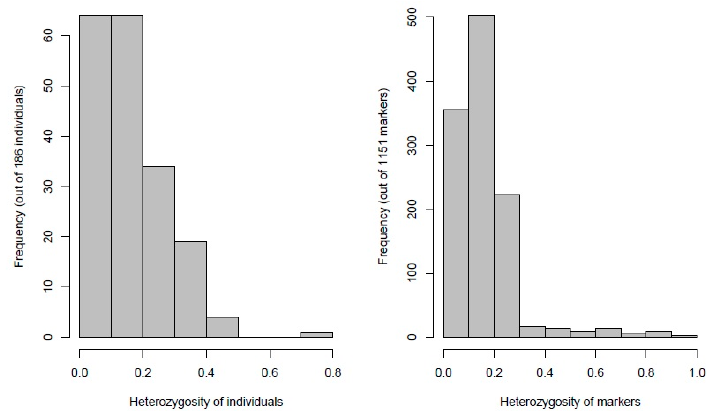
Figure 1. Percentage distribution of transition and transversion SNPs identified using DArTseq assay. Distribution of heterozygous chickpea genotypes and SNP markers revealed low values of heterozygosity (>0.2) in more than 75% of chickpea genotypes and SNP markers (Figure 2). These observations are to be expected since chickpea is a highly self-pollinated crop. Functional annotation of 1152 SNP variants showed the total of SNPs in genes was 917 (79.6%), of which (545) 59.4% were in exons. A total of 6669 functional effects for SNP variants were predicted for 1152 SNPs. The predicted effects were of modifier type (88.38%), moderate impact (3.72%), low impact (7.38%), and high impact (0.53%).